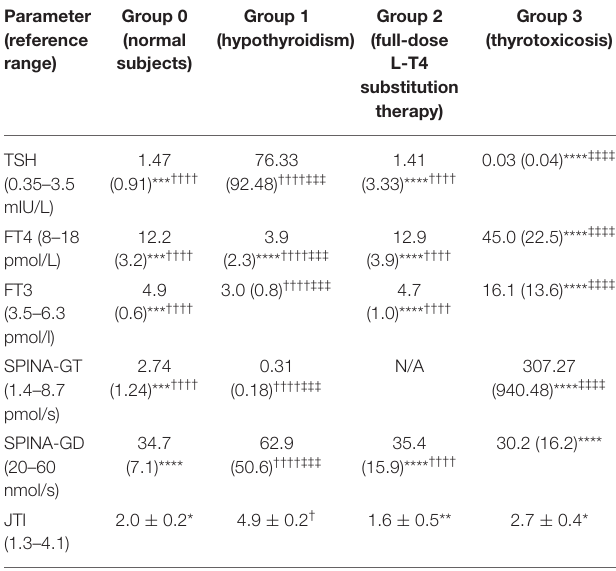
TABLE 2 | Measured and calculated parameters of thyroid homeostasis in the four groups. Parameter (reference